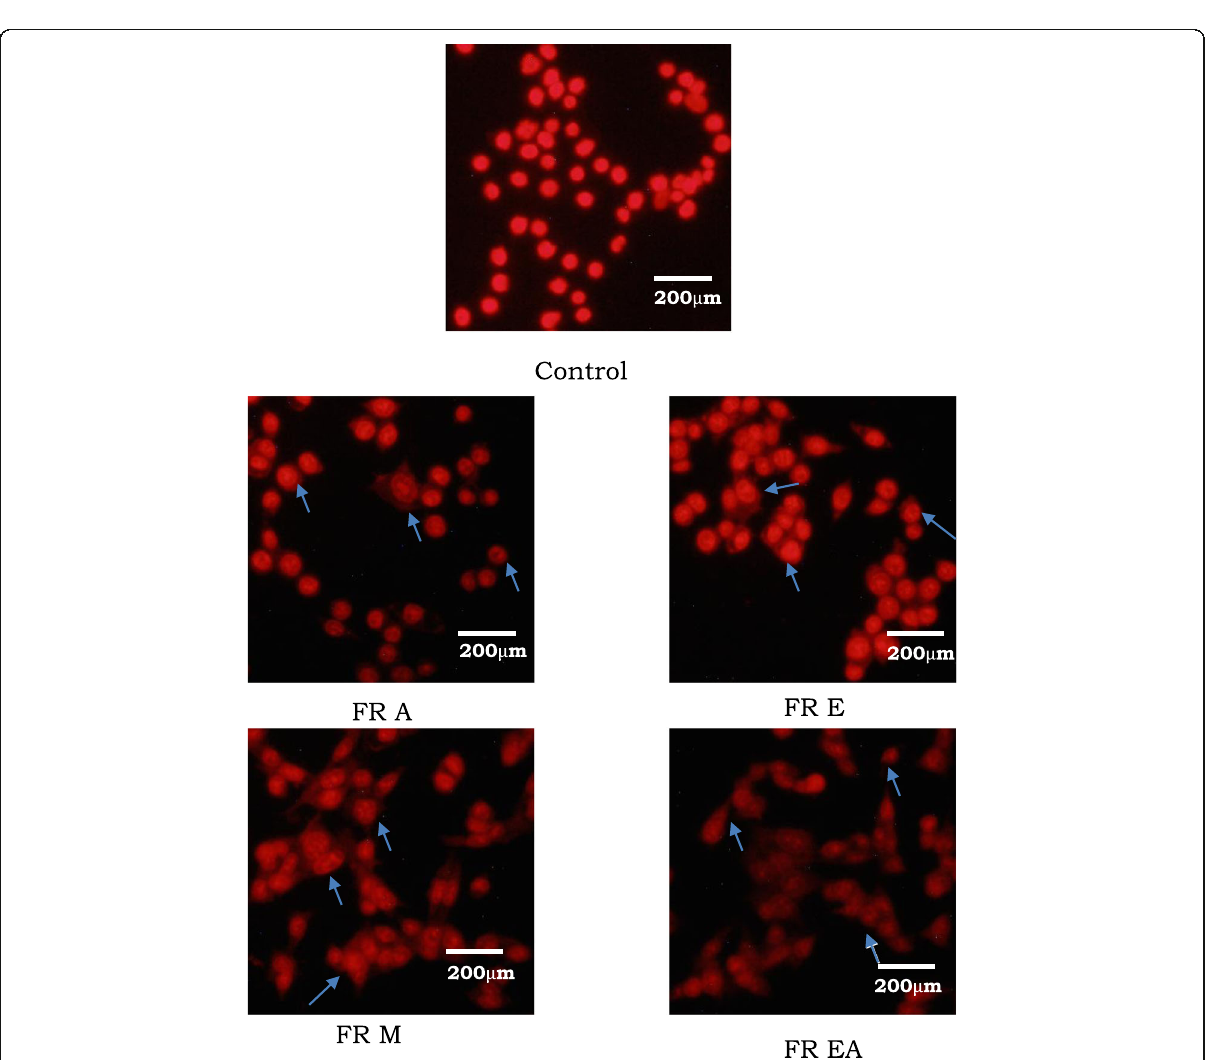
Fig. 5 Morphological changes observed in HCT 116 cells when treated with IC 50 concentrations of F. religiosa latex extracts along with control when stained with propidium iodide. A — acetone; E — ethanol; M — methanol; EA — ethyl